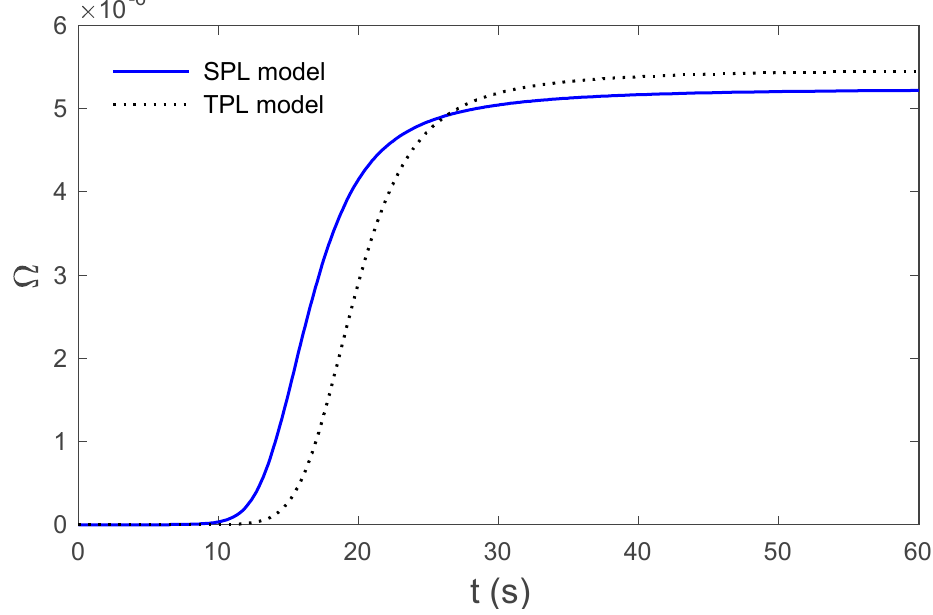
Figure 3. Temperature at the skin surface for the SPL and TPL models in relation to time.